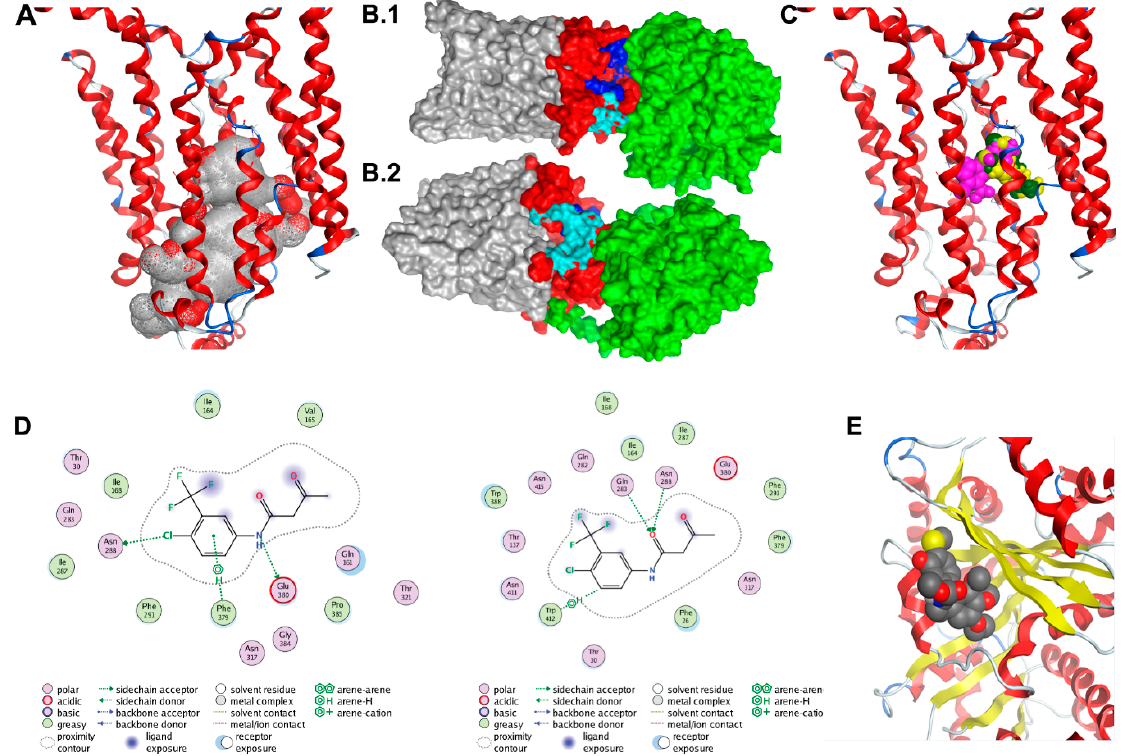
Figure 4. Docking studies of GLUT1-TUBB4. ( A ) Alpha spheres (grey and red spheres) obtained by applying molecular operating environment’s (MOE’s) Site Finder tool on the crystal structure of the human GLUT1 (Deng et al. 2014; PDB ID 4PYP) accounting for the most probable binding pocket. The binding region includes 69 residues, many of them being deeply buried within the channel. Contact atoms of the protein are highlighted in pink. ( B1 and B2 ) The molecular surface representation of the TUBB4-GLUT1 complex after 50 ns. TUBB4 is shown in green, the cytoplasmic domain of GLUT1 is red and both the transmembrane and extracellular domains of GLUT1 are shown in grey. Residues at the top channel opening are shown in blue while residues at the opening near the transmembrane domain are colored in cyan. At this predicted position, TUBB4 (green) occludes the top opening in the GLUT1 channel. ( C ) Most probable poses of fasentin as predicted from the 1st (green), 2nd (yellow) and 3rd (pink) most populated clusters. ( D ) Interaction diagrams of the most probable poses of fasentin as predicted from the 1st (top) and 3rd (bottom) most populated clusters. ( E ) Docking model of CR-42-24 and TUBB.